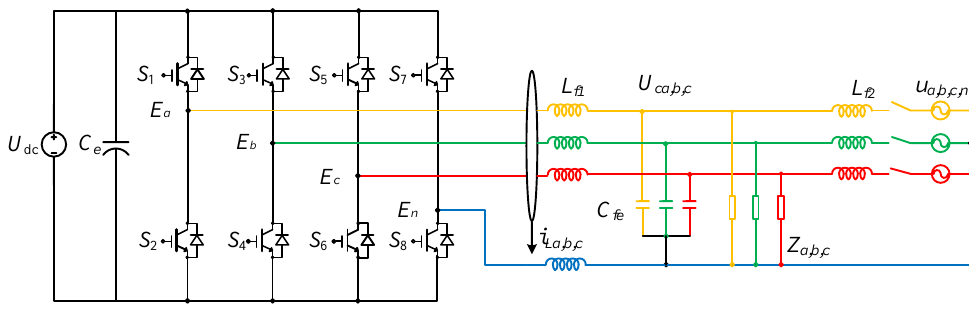
Figure 12. Schematic of the 3P4L inverter.